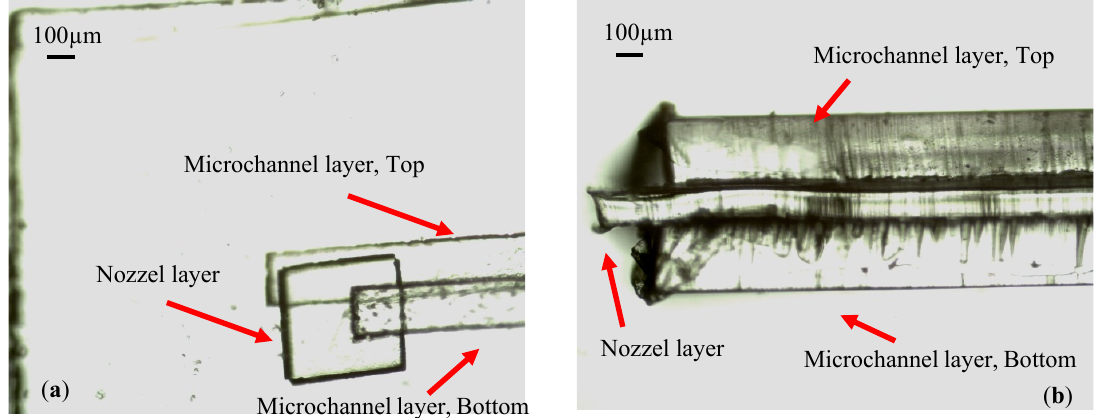
Figure 10. ( a ) Top view of the three microchannels and nozzle layers with an undesired offset; ( b ) side view of a fabricated SPMF 3 with undesired offset between layers.